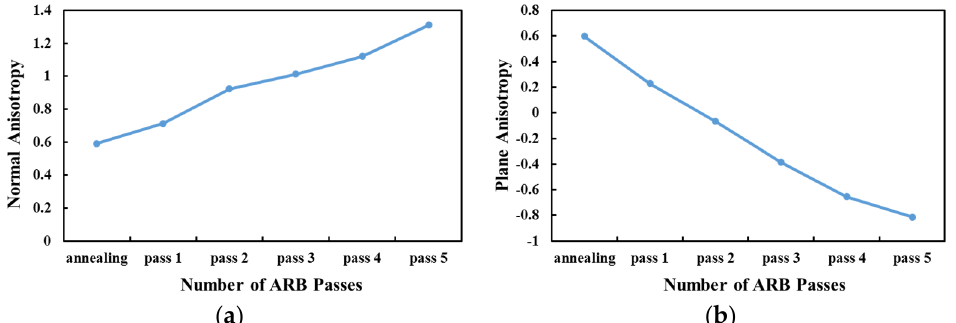
Figure 10. ( a ) Normal anisotropy; ( b ) plane anisotropy of the annealed sample and ARBed sam- ples